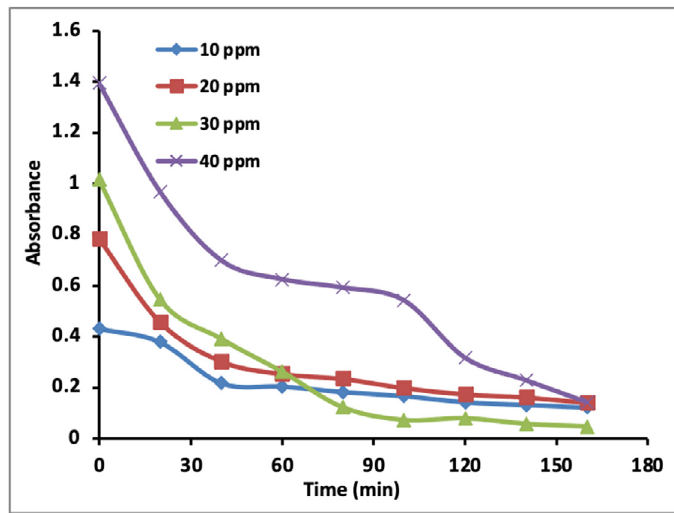
Fig. 9. Effect of concentration of Industrial wastewater on